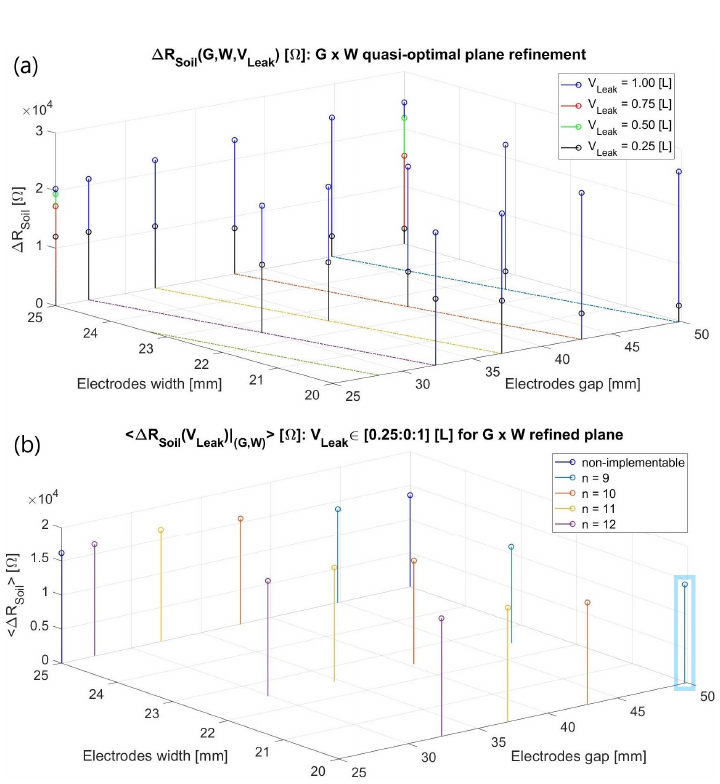
Figure 5. ( a ) Heuristically optimal G × W refinement for doable dimensions according to (3). A color pattern was established for n ranging from 13 (greenish) to 9 (blueish); ( b ) Averaged outcomes for implementable extensions, the final selected (G, W) = (5, 2) cm being highlighted in blue.